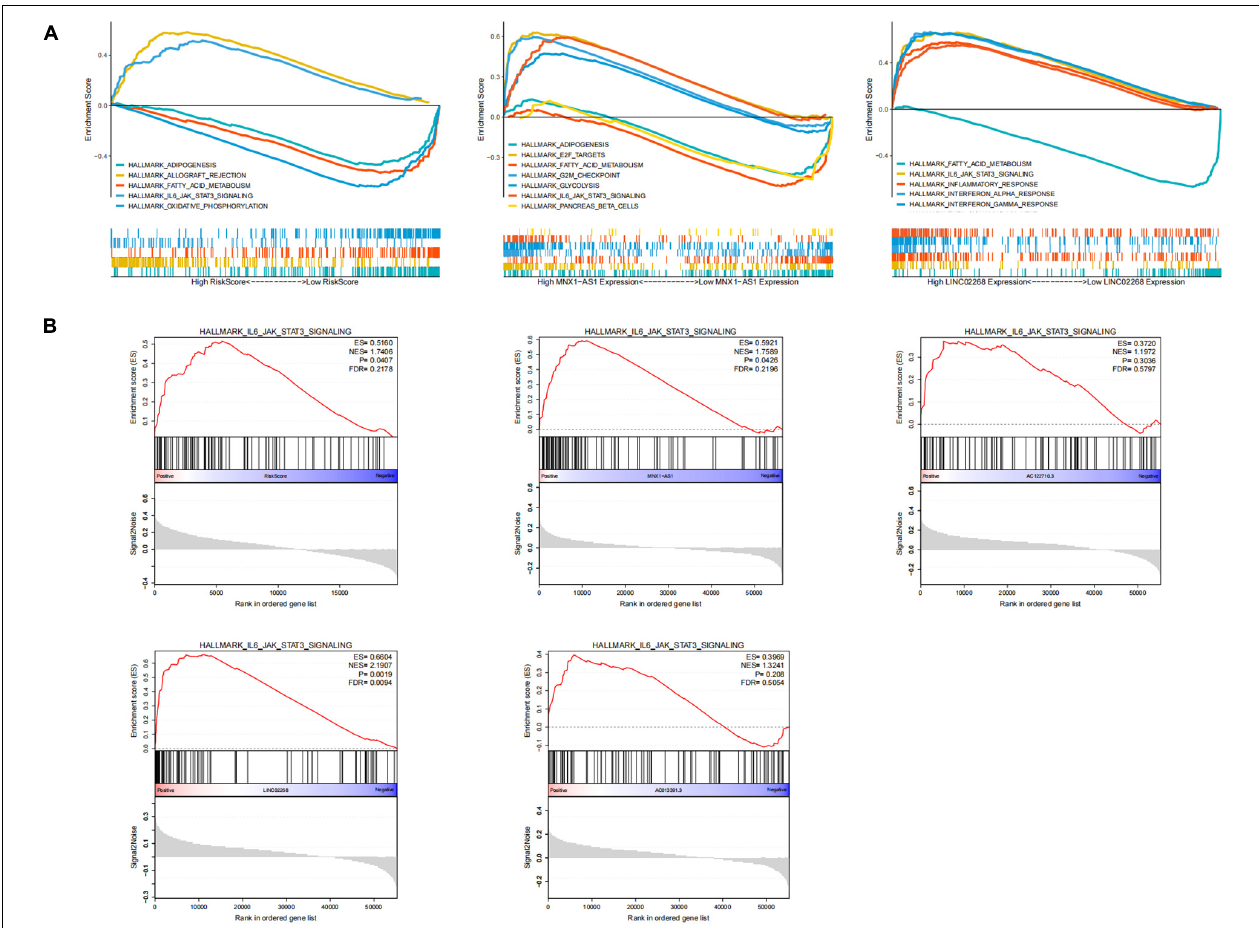
FIGURE 7 | Identification of the biological functions of lncRNAs in GILncSig. (A) Multi-GSEA result of significant enrichment pathways about MNX1-AS1, LINC02268, and GILncSig. (B) The enrichment of the IL6/JAK/STAT3/SIGNALING pathway among MNX1-AS1, AC013391.3, AC122710.3, LINC02268, and GILncSig. The IL6/JAK/STAT3/SIGNALING pathway can be activated by MNX1-AS1, AC013391.3, AC122710.3, LINC02268, and GILncSig, while only MNX1-AS1, LINC02268, and GILncSig showed significant correlation ( p <